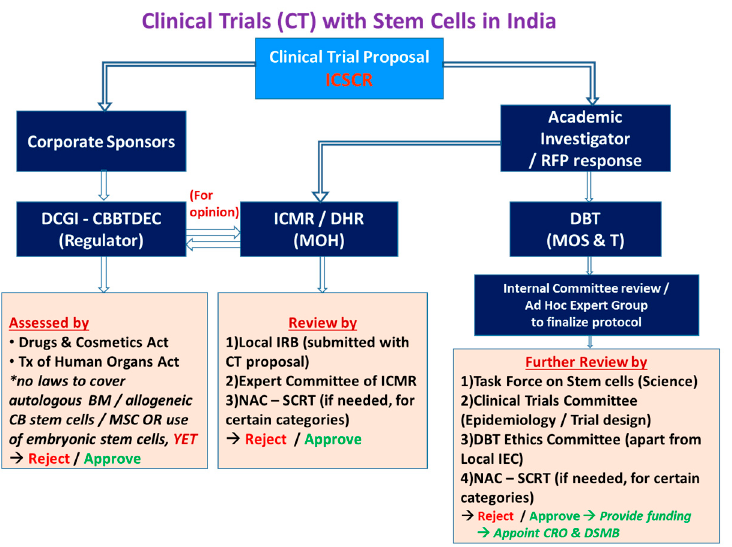
Figure 1. Clinical trial with stem cell in India.